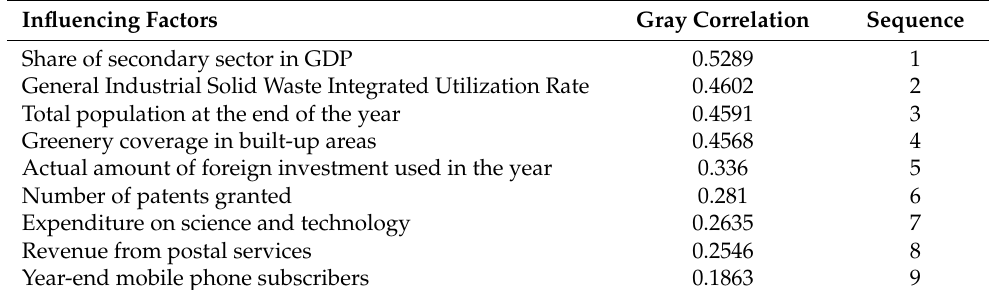
Table 2. The gray correlation between water pollution in the Yangtze River Delta and various factors from 2004 to